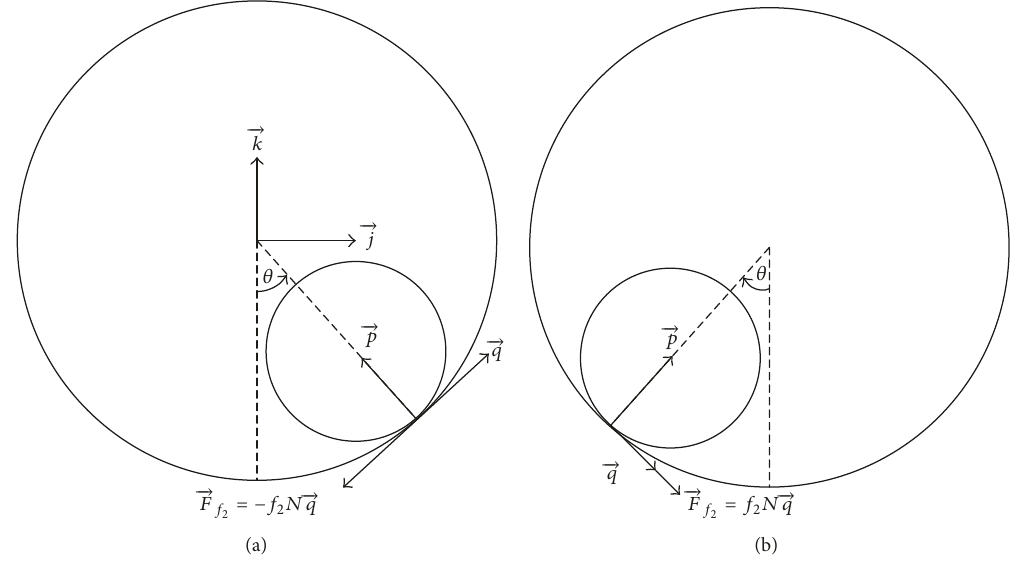
Figure 3: Direction of tangential